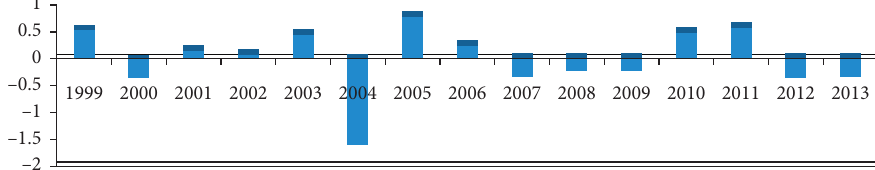
Figure 7: Mean annual deviation in maximum temperature ( ° C) in the Bawku Municipality.